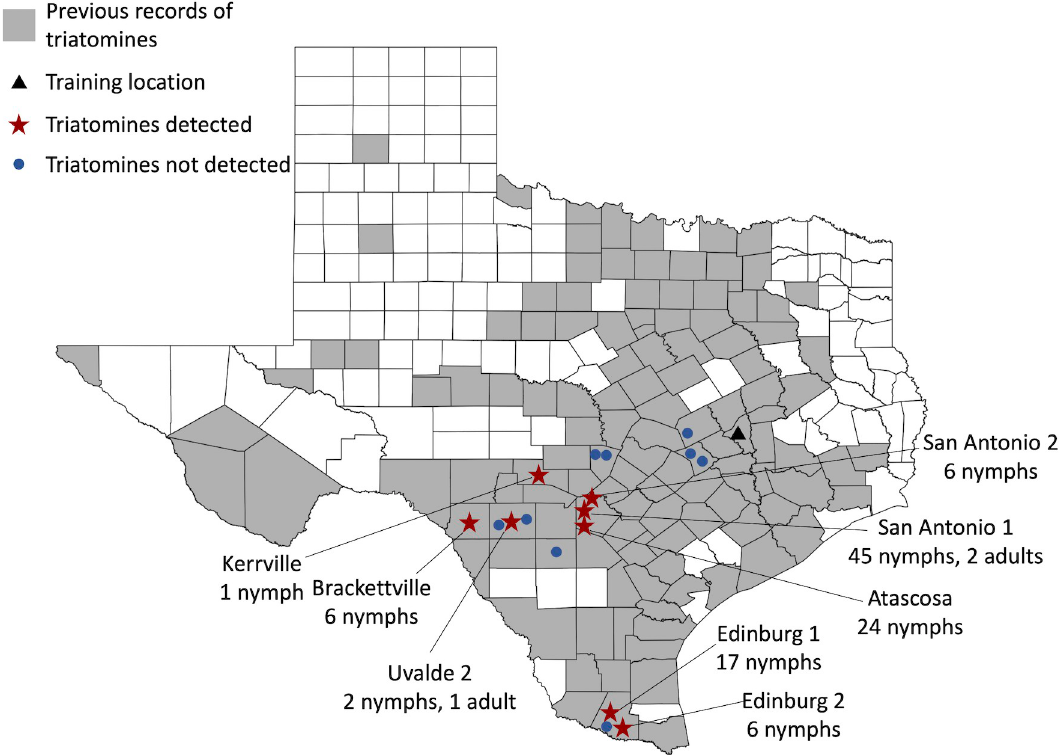
Fig 1. Training and field sites across Texas where triatomine scent detection efforts by a trained dog were conducted. Dog scent detection efforts were conducted at locations where kissing bugs had been submitted by community scientists or collected by our field team previously. Initial training for this study took place in College Station (triangle). Triatomines were found at 8 of the 17 sites searched. Previous records of triatomines are based on our field collections and submission to the Kissing Bug Community Science Program [18]. Base map created using QGIS [49] with Texas counties data file from https://data.texas.gov/dataset/Texas-Counties- Map/48ag-x9aa